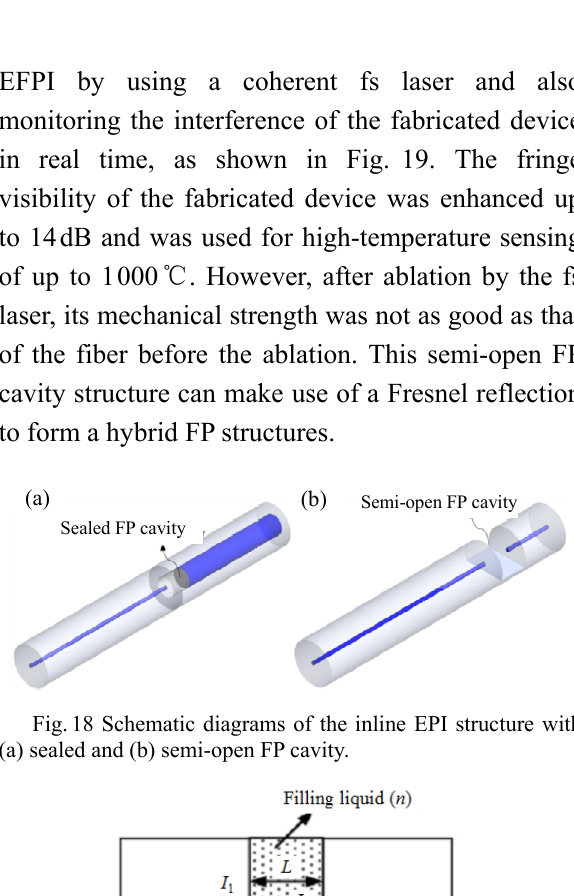
Fig. 17 Schematic diagrams of diaphragm-type EFPI structure when the diaphragm is functioned as an FP cavity.